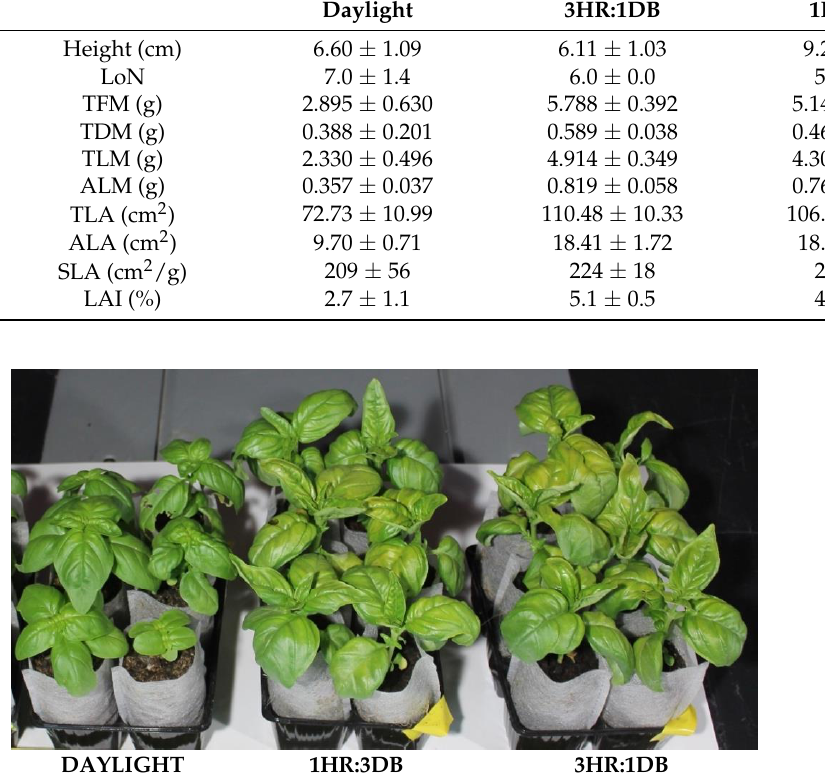
Figure 4. Basil plants at the end of the growth test performed under different lights and with the Organic soil as substrate .